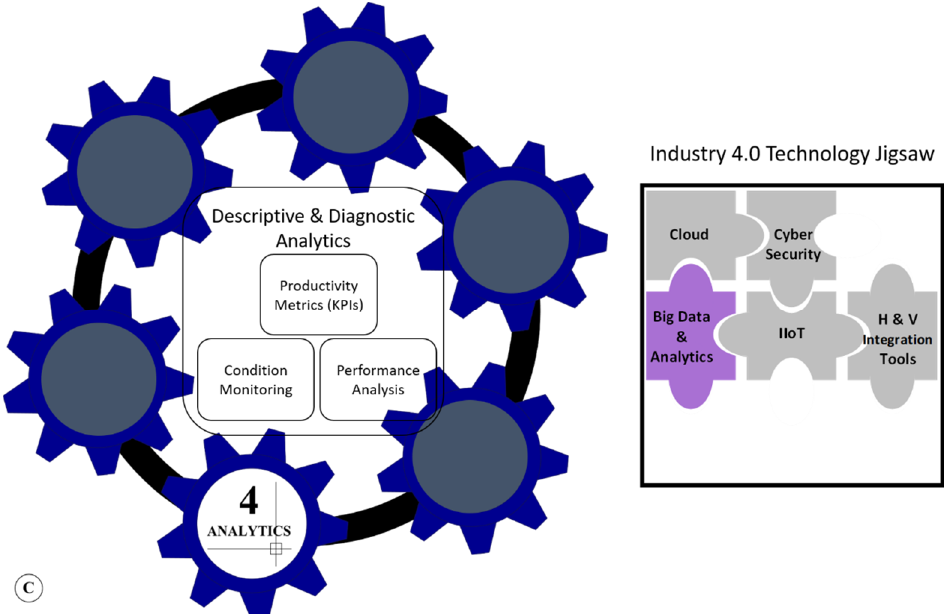
Figure 11. Gear 4—analytics stage and Industry 4.0 technology jigsaw (Primary technologies represented in color, secondary technologies represented in grey).